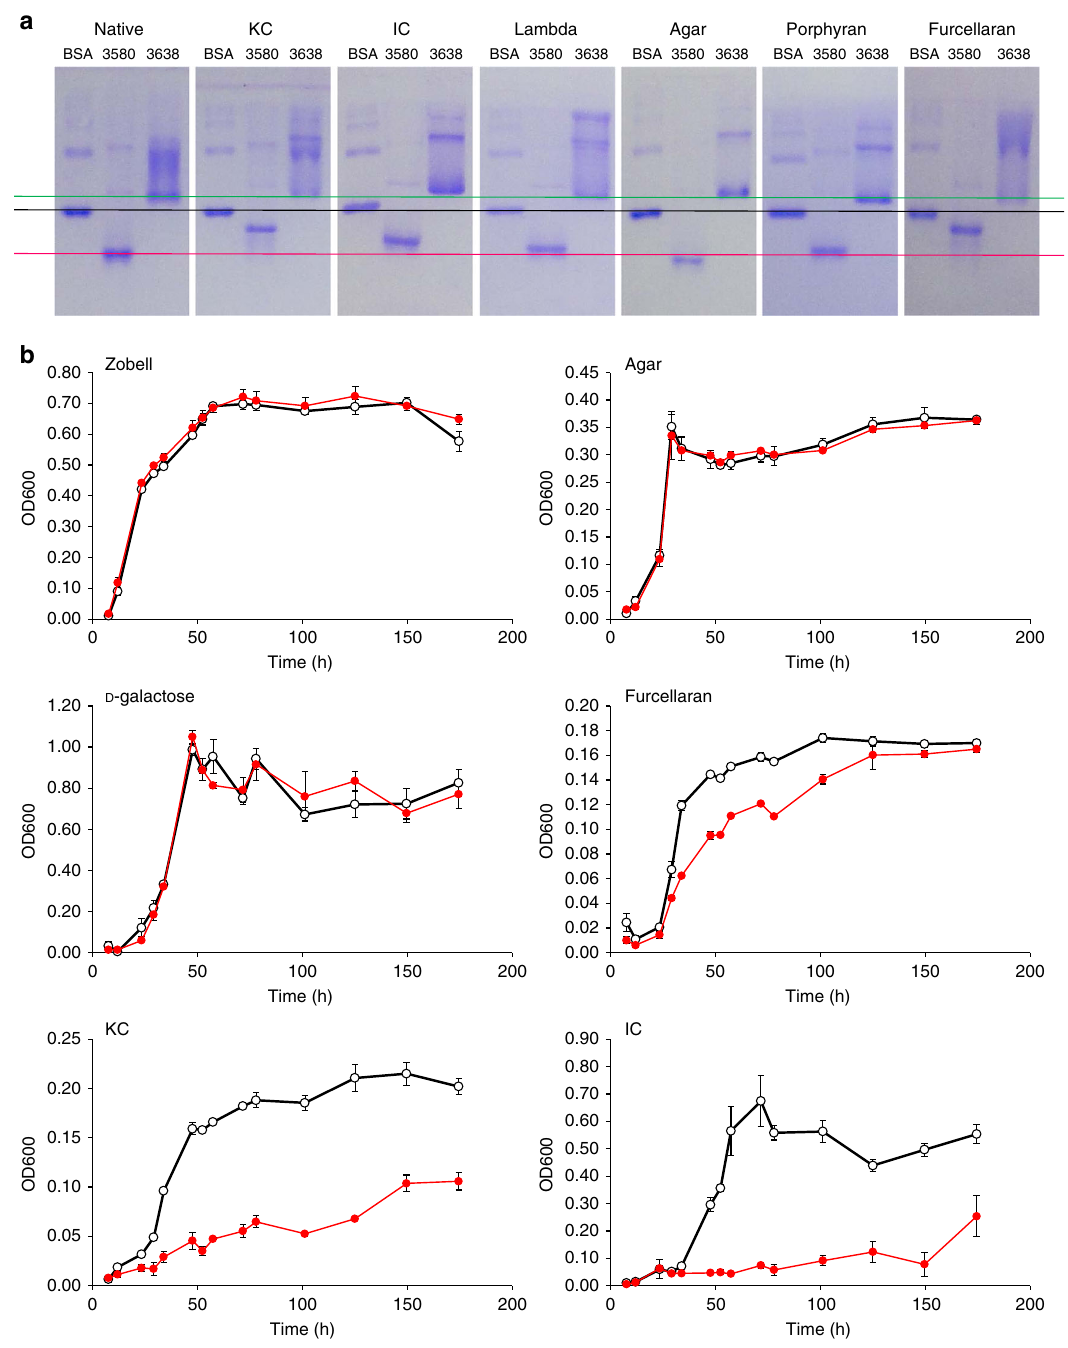
Fig. 8 Af fi nity gel electrophoresis for the SusD-like proteins and phenotyping for the susCD -like mutant Δ cgtA-cgtB . a BSA and recombinant ZGAL_3580 (CgtB, SusD-like) and ZGAL_3638 (SusD-like) migrated at 60 V over 5 h in native-PAGE gels or in gels containing different red algal cell wall polysaccharides. The delay of migration for ZGAL_3580 (red line) and ZGAL_3638 (green line) was compared between the native gels and the polysaccharide containing gels by comparison with BSA (black line). b Growth curves for wild-type Z. galactanivorans (black curves) and Δ cgtA-cgtB (red curves) in rich Zobell media and in minimal media containing different carbohydrate